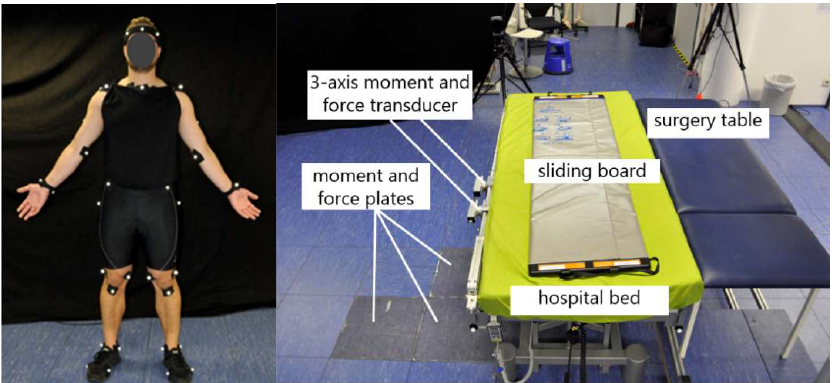
Figure 3. Full-body labeled test person (left side) and application mock-up (right side) in the biomechanical laboratory with integrated force and moment sensors to detect external loads.